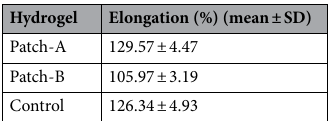
Table 5. Elongation test of the GbH